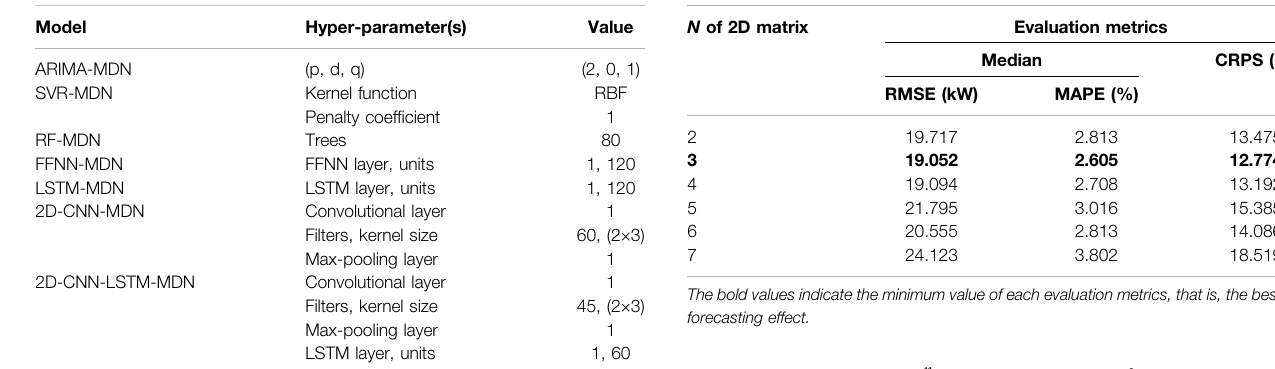
TABLE 2 | Hyper-parameters of the contrast models. TABLE 3 | Forecasting results of each N